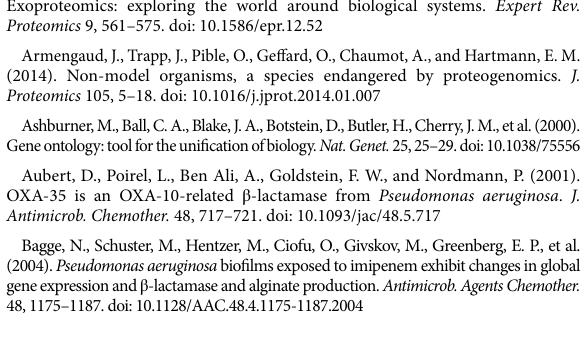
SUPPLEMENTARY TABLE 5 List of regulatory proteins of Pseudomonas aeruginosa CCUG 70744 that were differentially regulated in at least one sub-MIC. The table includes their relative abundances (sub-MICs vs. no antibiotic; if quantitated), basal relative abundance compared to strain PAO1 (if fulfilling the criteria for being included in the inter-strain comparison, i.e., ≥ 99% of sequence identity and with 100% coverage over the longer protein), P. aeruginosa PAO1 orthologues and functional annotations. Orthologous proteins differentially regulated in both strains are in bold and shaded. Gene expression data from the publicly available transcriptomic dataset that analyzed biofilms of P. aeruginosa PAO1 treated with meropenem (5 μ g/ ml) vs. no antibiotic (GEO accession number: GSE167137) is included in columns AA – AC. SUPPLEMENTARY TABLE 6 List of proteins of Pseudomonas aeruginosa CCUG 51971 annotated as “hypothetical proteins” or as proteins with domain of unknown function in RefSeq that were differentially regulated in at least one sub-MIC. The table includes their relative abundances (sub-MICs vs. no antibiotic; if quantitated), basal relative abundance compared to strain PAO1 (if fulfilling the criteria for being included in the inter-strain comparison, i.e., ≥ 99% of sequence identity and with 100% coverage over the longer protein), P. aeruginosa PAO1 orthologues and functional annotations. Orthologous proteins differentially regulated in both strains are in bold and shaded. Gene expression data from the publicly available transcriptomic dataset that analyzed biofilms of P. aeruginosa PAO1 treated with meropenem (5 μ g/ml) vs. no antibiotic (GEO accession number: GSE167137) is included in columns AA – AC. SUPPLEMENTARY TABLE 7 List of proteins of Pseudomonas aeruginosa CCUG 70744 annotated as “hypothetical proteins” or as proteins with domain of unknown function in RefSeq that were differentially regulated in at least one sub-MIC. The table includes their relative abundances (sub-MICs vs. no antibiotic; if quantitated), basal relative abundance compared to strain PAO1 (if fulfilling the criteria for being included in the inter-strain comparison, i.e., ≥ 99% of sequence identity and with 100% coverage over the longer protein), P. aeruginosa PAO1 orthologues and functional annotations. Orthologous proteins differentially regulated in both strains are in bold and shaded. Gene expression data from the publicly available transcriptomic dataset that analyzed biofilms of P. aeruginosa PAO1 treated with meropenem (5 μ g/ml) vs. no antibiotic (GEO accession number: GSE167137) is included in columns AA – AC.